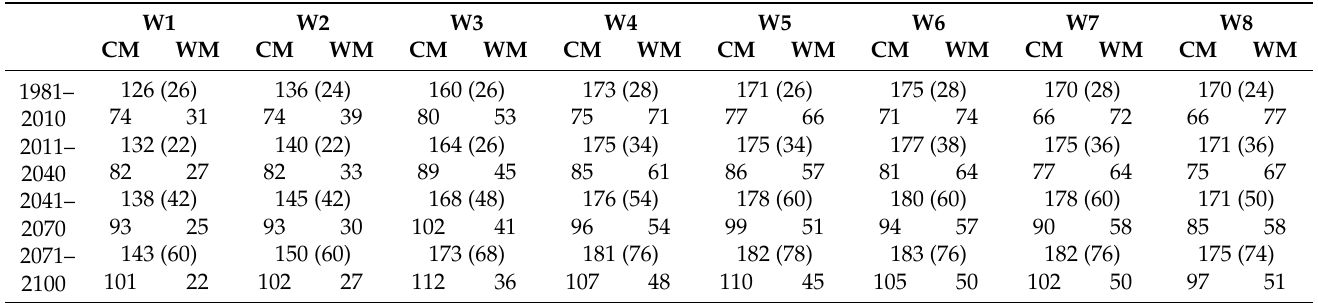
Table 4. Thirty-year evolution of mean groundwater recharge (mm/yr), range of the ensemble changes (in brackets), and evolution of the cold month groundwater recharge from December to March (T < 0 ◦ C) and that from May to November (T > 0 ◦ C) (mm) of the 12 climate scenarios for the eight watersheds (W1 to